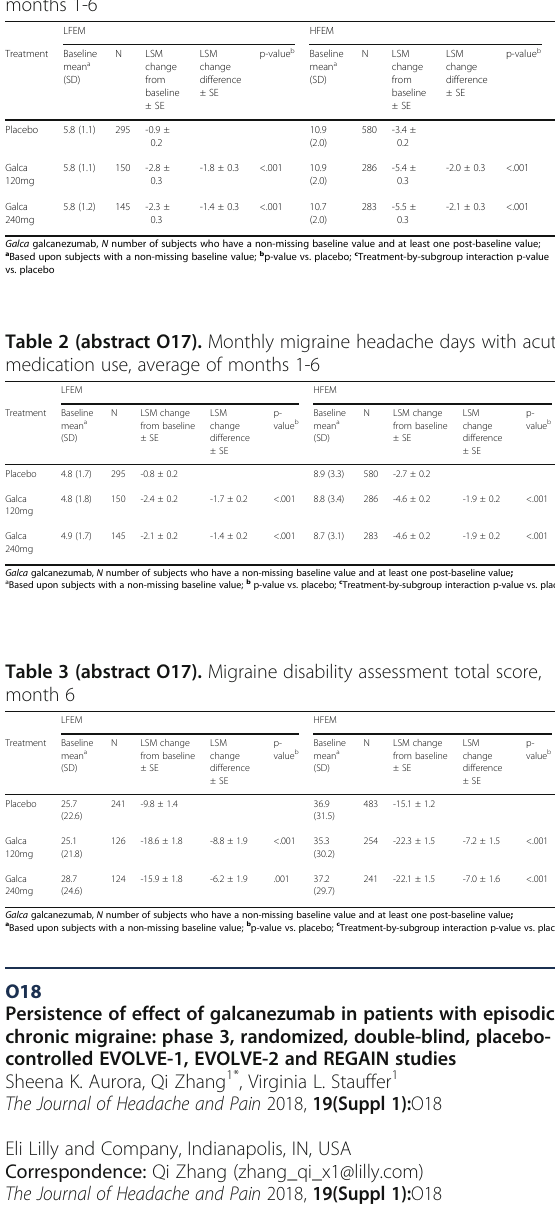
Objectives : To describe the persistence of effect following treatment with galcanezumab in adult patients with episodic or chronic migraine. Methods : Data from two parallel studies (EVOLVE-1=NCT02614183, EVOLVE-2=NCT02614196) of patients with episodic migraine (be- tween 4 and 14 migraine headache days [MHD] and at least 2 mi- graine attacks per month during baseline) and one study (REGAIN=